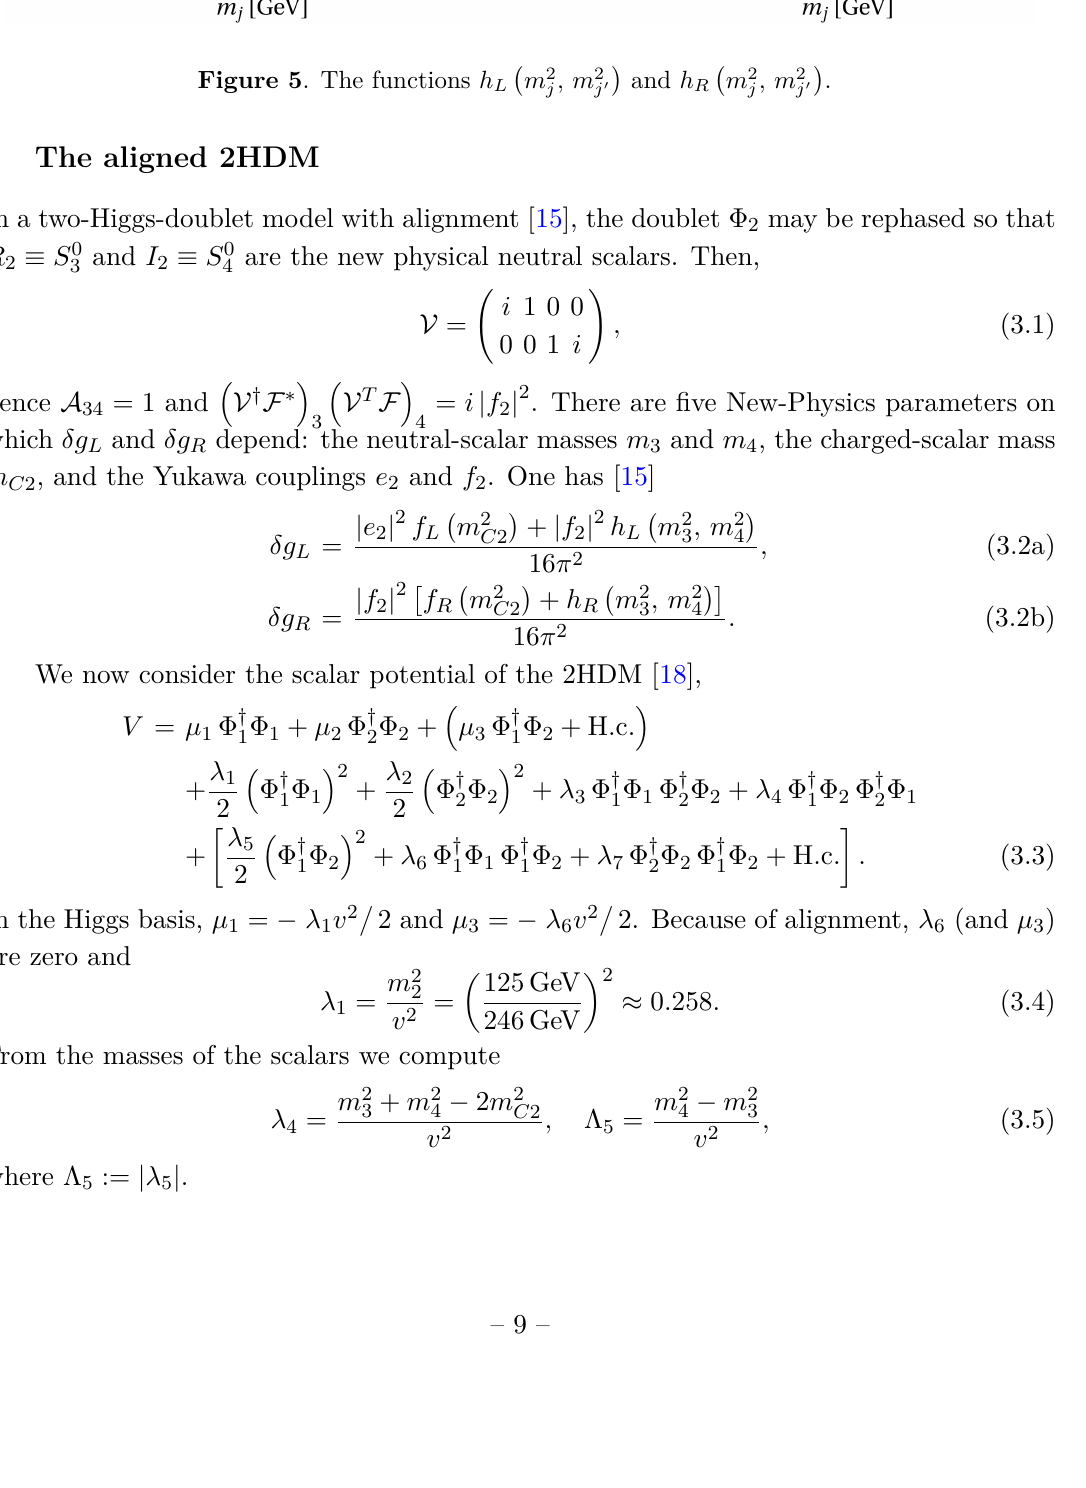
Figure 5 . The functions h L